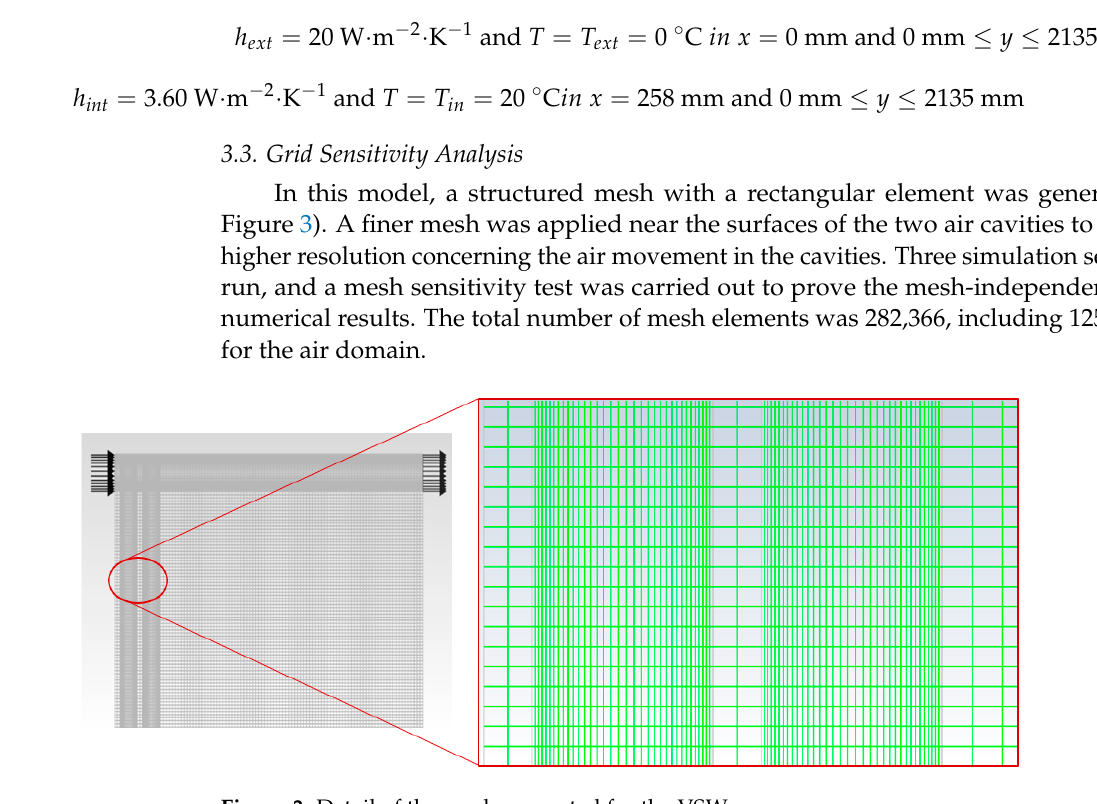
Figure 3. Detail of the mesh generated for the VSW.